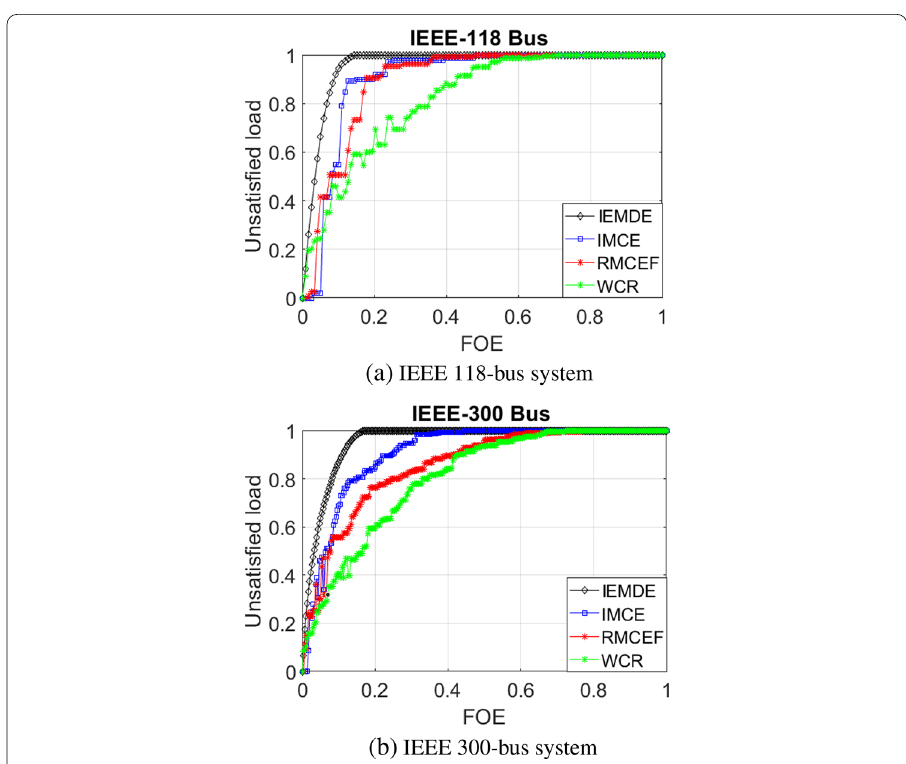
Fig. 8 Vulnerability curves for different attack strategies: IEMDE, WRC, IMCE (for PTM degree) and RMCEF (for PTM degree) performed